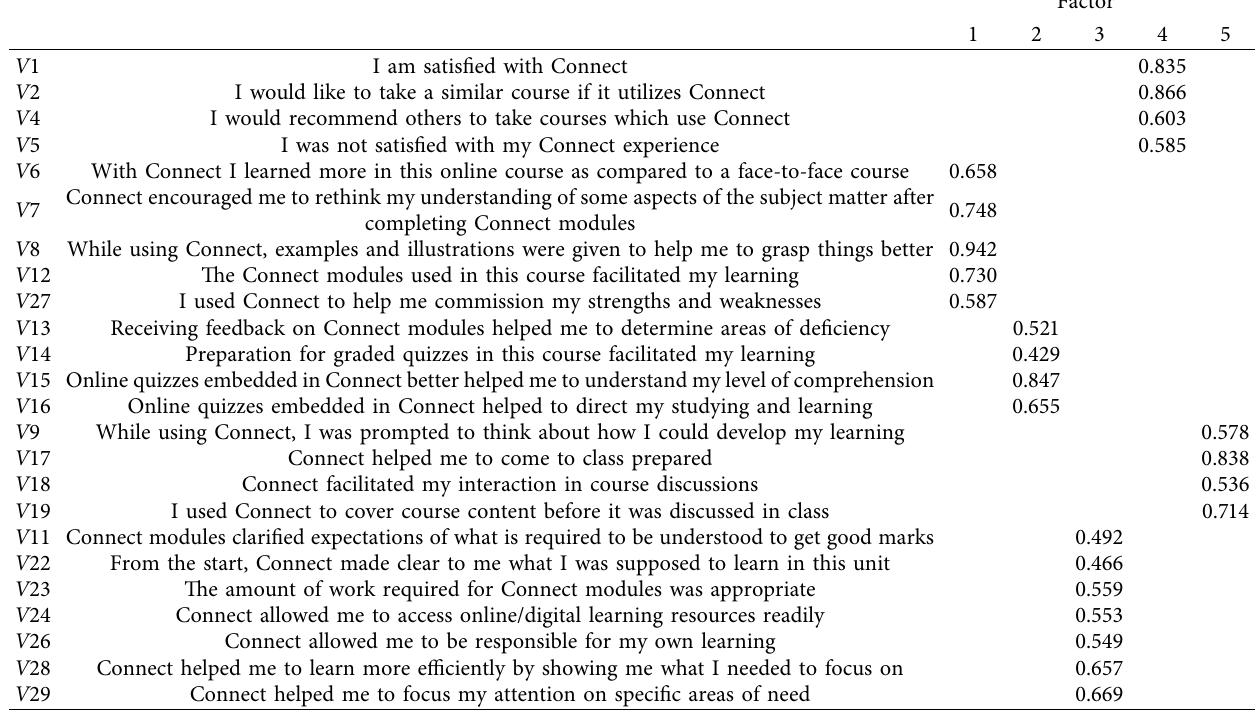
Table 3: Item loadings on rotated extracted factors after deleting 10 and 21.